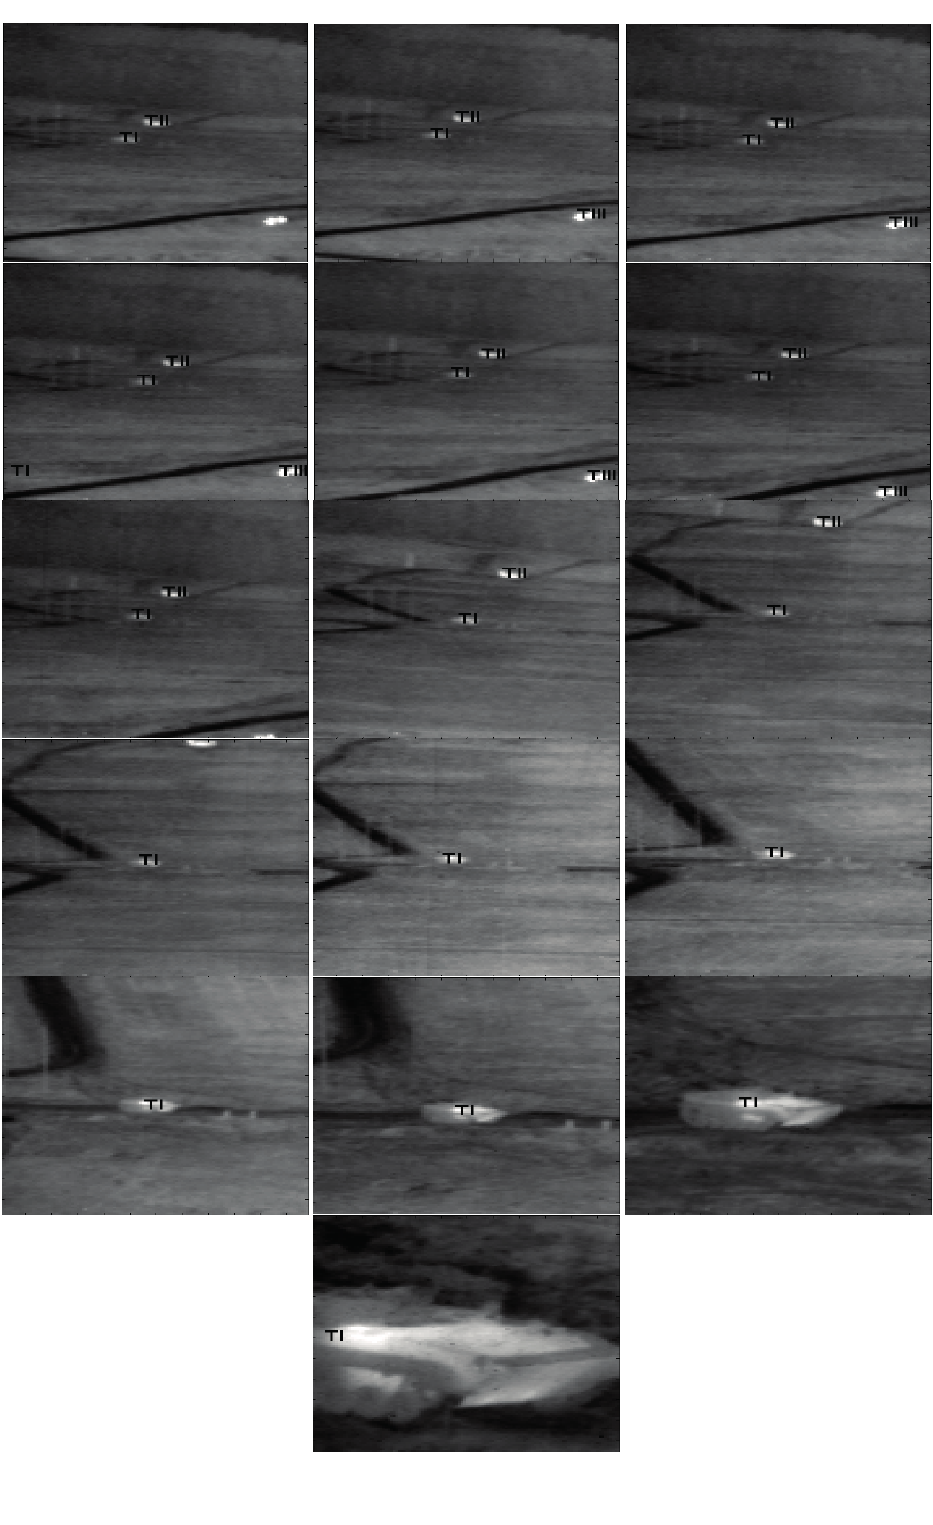
Figure 11. Target detection and classification results of Sequence